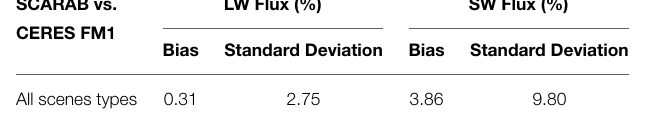
TABLE 4 | Statistics of comparison between SCARAB and CERES TOA SW flux. SCARAB